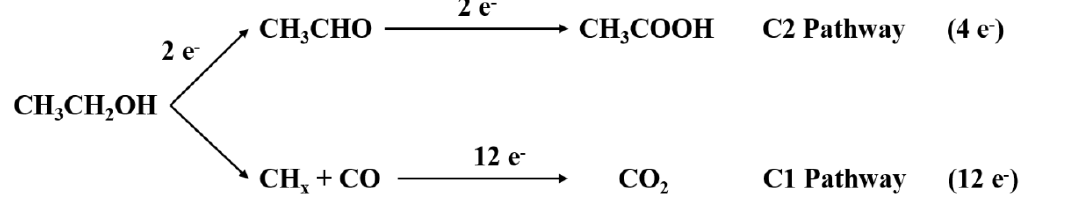
Figure 1. Schematic representation of the parallel pathways for ethanol oxidation on Pt electrodes in acidic